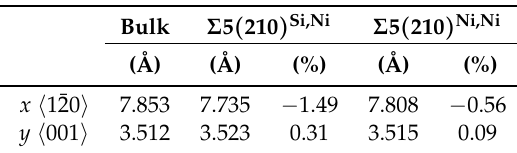
Table 1. The calculated lattice parameters within the (210) interface plane of the studied GBs. The values are compared with those obtained for the bulk for the same plane. The lattice parameters along the (cid:104) 1¯20 (cid:105) direction, x , and (cid:104) 001 (cid:105) direction, y (see Figure 1) are included together with their changes (expressed relatively in % with respect to the bulk). Bulk